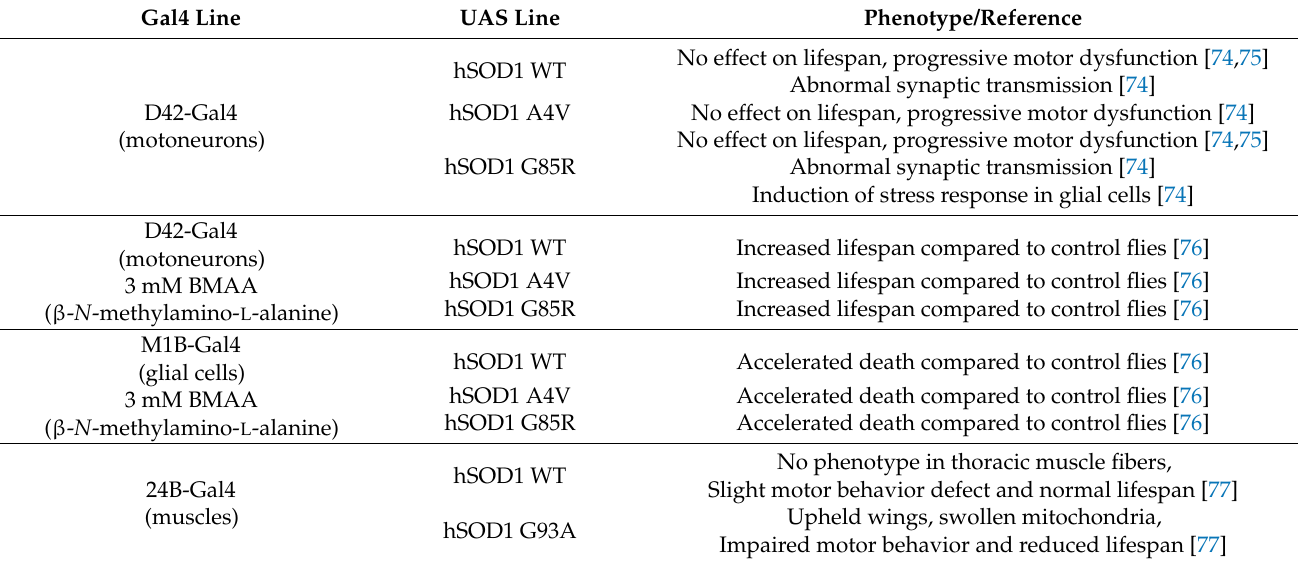
Table 2. Gain-of-function phenotypes induced by hSOD1. WT,